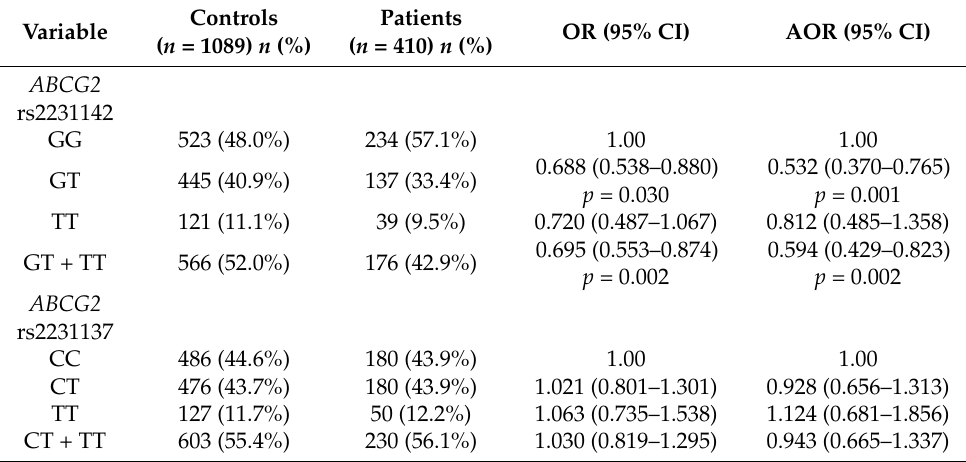
Table 2. Distribution of ABCG2 genotype frequencies in 1089 controls and 410 psoriasis patients.